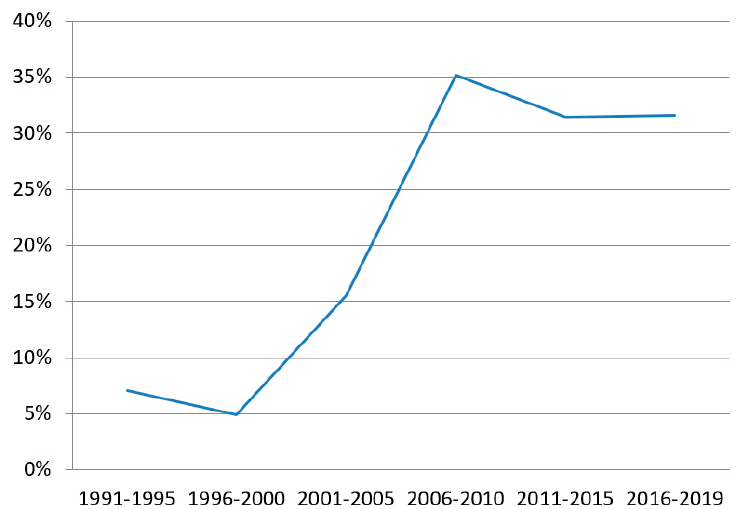
Figure 1. Percentage of carbapenem-resistant Pseudomonas aeruginosa in bloodstream infections though time.